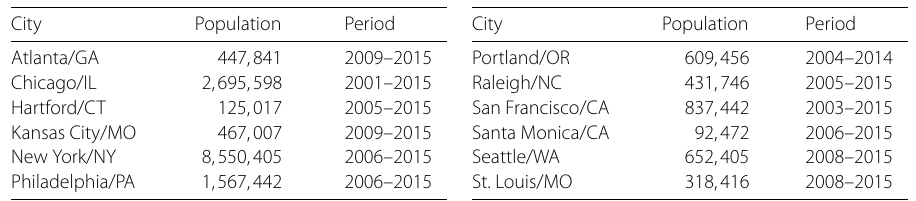
Table 1 Official disaggregated data sets of offences from different locations in the U.S. City Population